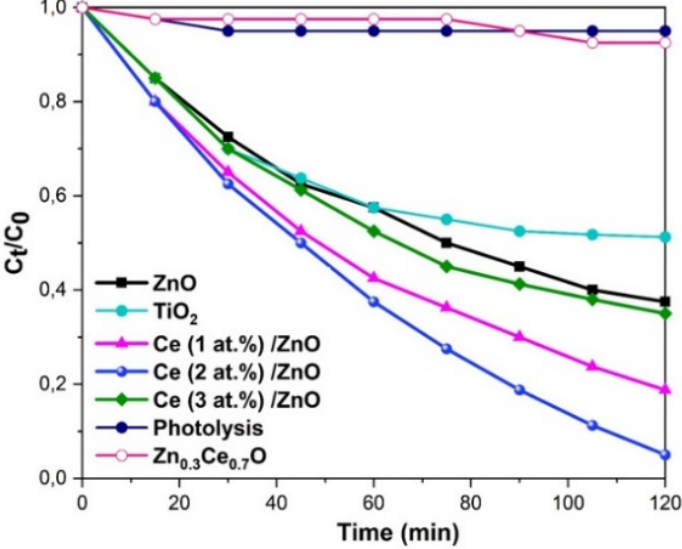
Figure 12. Photodegradation of methylene blue (MB) in the presence of the different ZnO:Ce photocatalysts, TiO 2, Ce 0.7 Zn 0.3 O x and without any photocatalyst. Table 3. Numerical values of the effective rate constant estimated using the LH model.